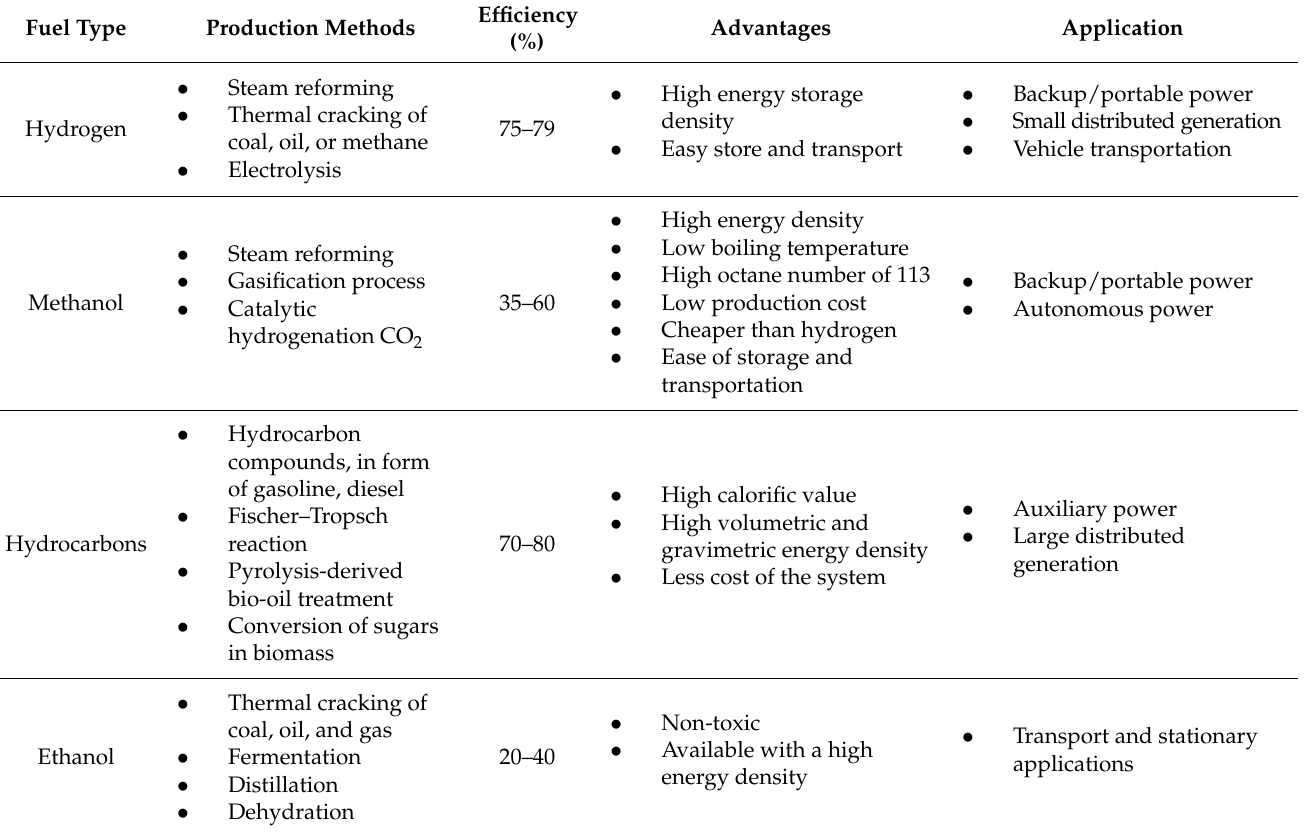
Table 1. A summary of fuels used in